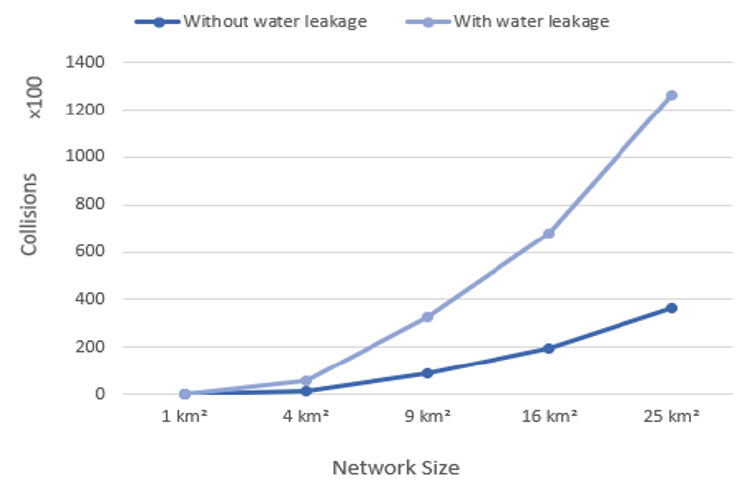
Figure 8. Collisions versus network